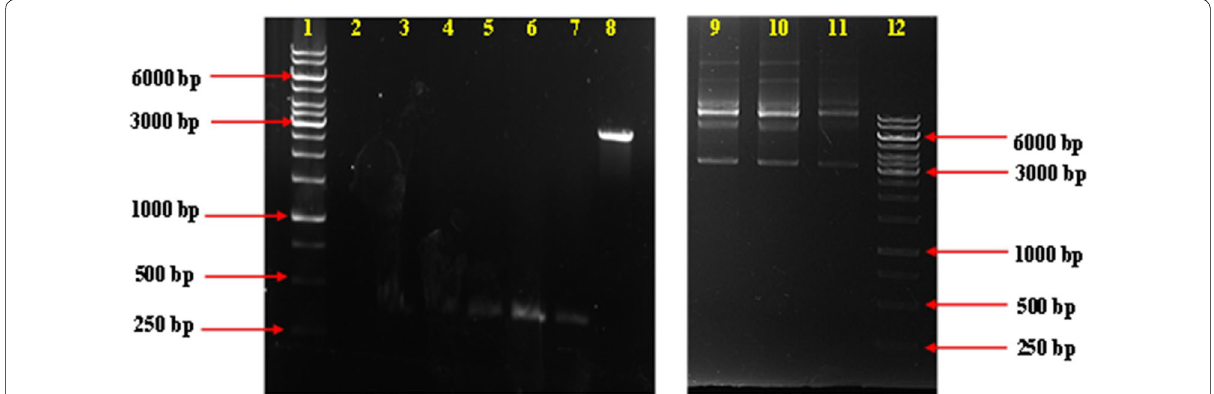
Fig. 1 Images displaying the PCR amplicons of proinsulin DNA, purified vector DNA, and the integrated pET21b-hPin vector with the inserted proinsulin gene. Lanes 1 and 12 contain one kb molecular weight marker. Lanes 2 to 7 contains the PCR amplicons of proinsulin flanked with BamHI and XhoI restricted ends; Lane 8 contains the purified pET21b miniprep product; Lanes 9 to 11 contain the integrated pET21b-hPin vector miniprep